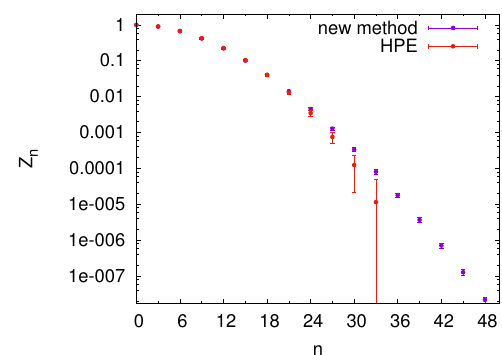
Figure 2. Dependence of Z n on n for T / T c = 0 . 93 for two methods of